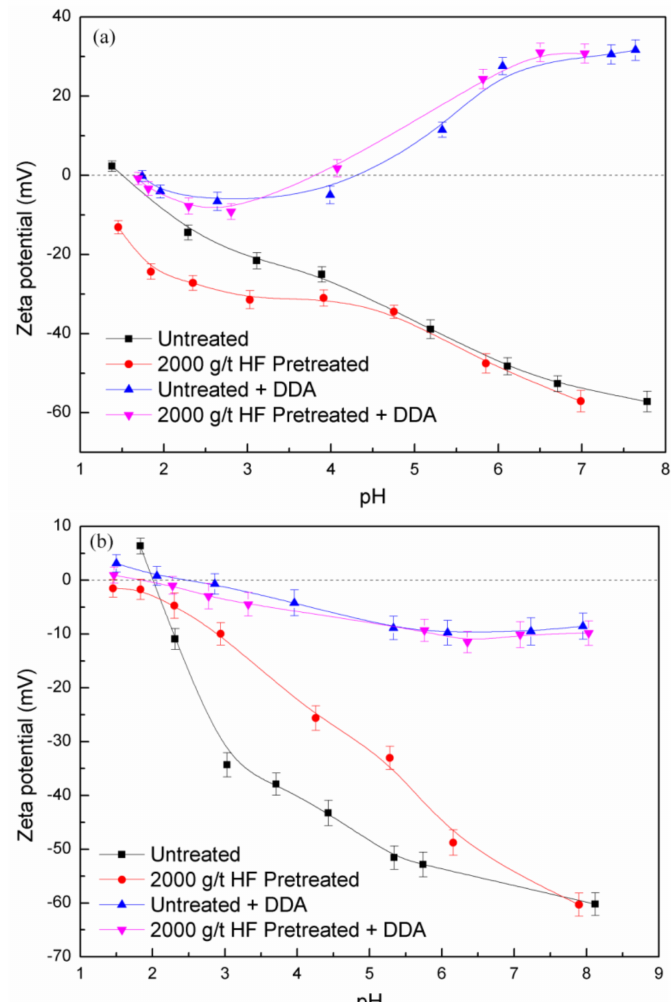
Figure 4. Zeta potentials of feldspar ( a ) and quartz ( b ) as a function of pH and HF